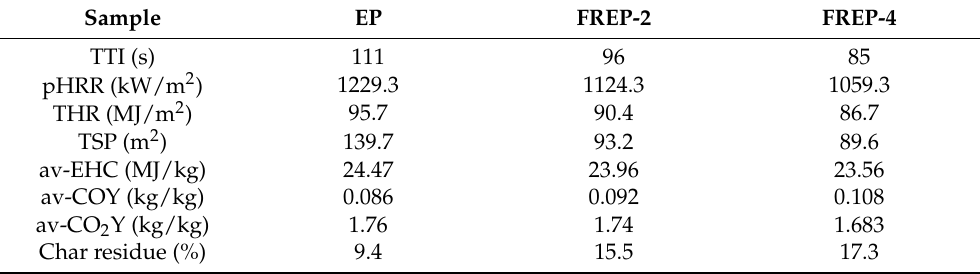
Figure 2. The variations of the HRR ( a ), the THR ( b ), the SPR ( c ), and the TSP ( d ) with the time. Table 5. Some crucial data from the CCTs for the pure EP and the FREPs.